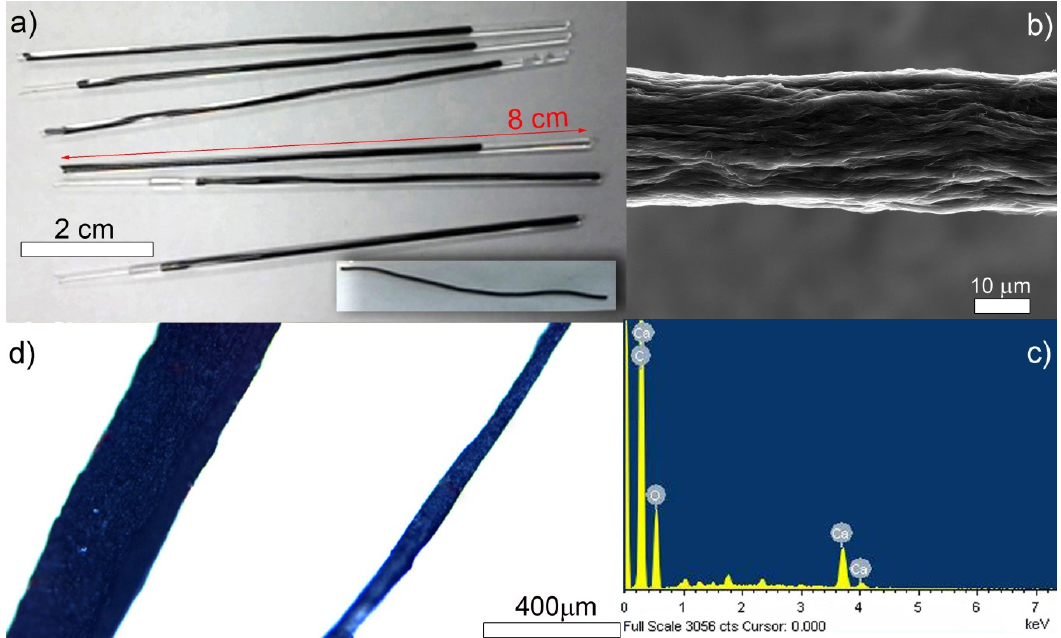
Figure 1. ( a ) Hydrogel in tubes after hydrothermal synthesis; (inset) fiber taken out for drying in ambient conditions (scale 1:1 with main image, glass tube length 8 cm), dried fiber is too small to be visible in this scale; ( b ) SEM micrograph of partially reduced graphene oxide fibers ~60 µ m diameter; ( c ) energy dispersive X-ray spectroscopy (EDX) plot of the fiber; ( d ) optical microscope image of partially dried (~300 µ m) and fully dried (~40–100 µ m) diameter